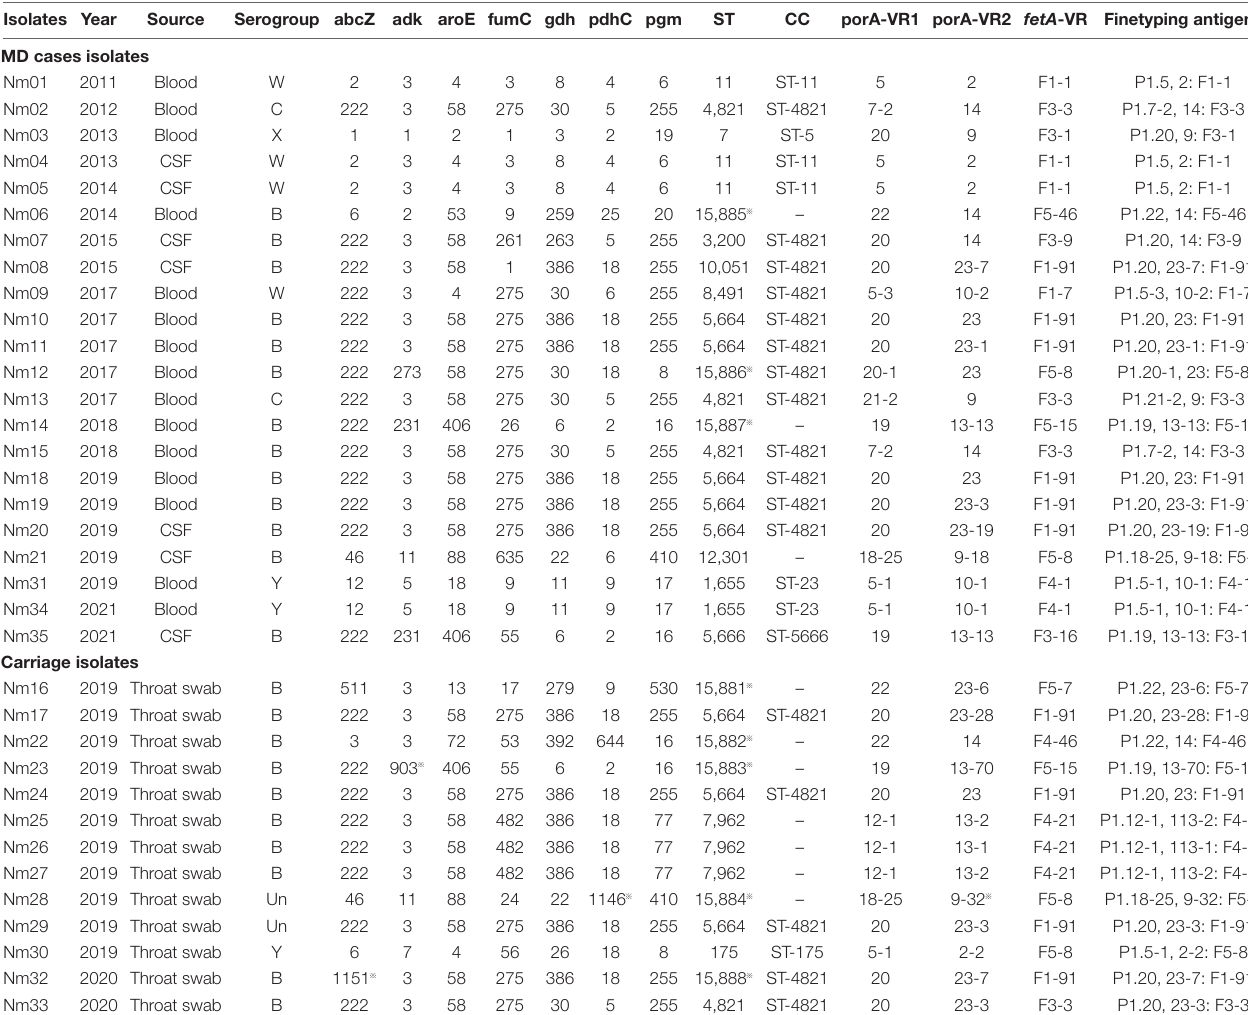
TABLE 3 | MLST and Finetyping antigen characteristics of Nm isolates from both MD cases and